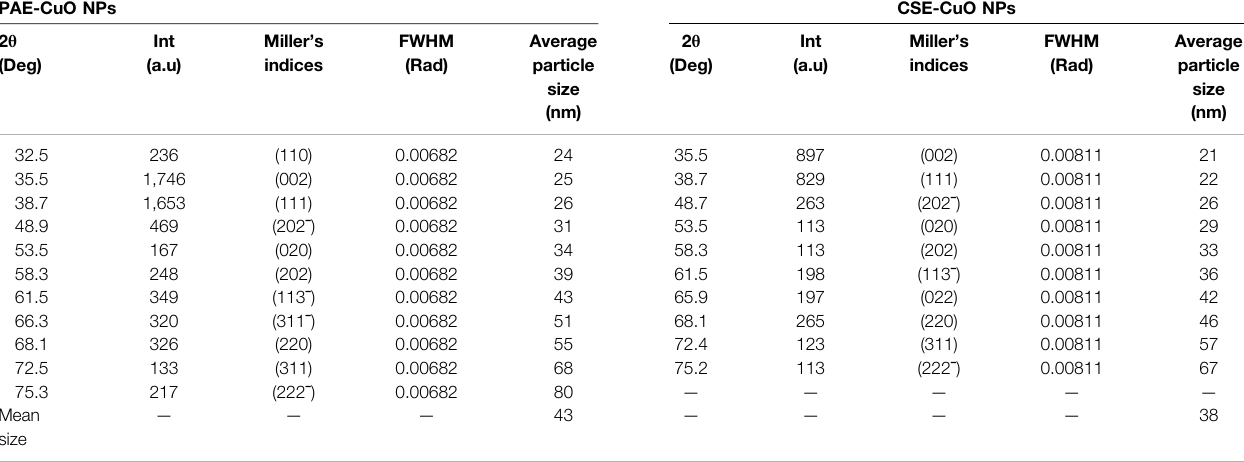
TABLE 1 | 2 θ angles and their corresponding Miller ’ s incident, peak intensity, and average crystal size of CSE and PAE phytosynthesized nanoparticles. PAE-CuO